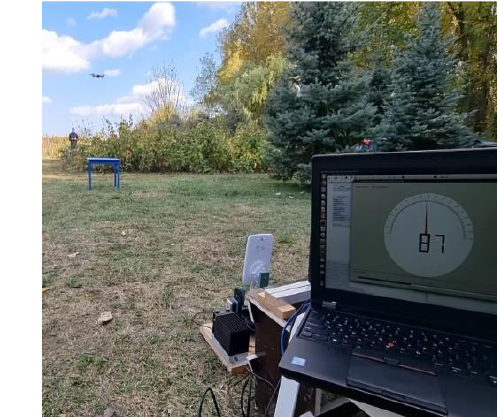
Figure 5. Tests performed using the DronEnd ground system (DJI Mavic AIR target drone). The estimated angle of incidence can be noticed.